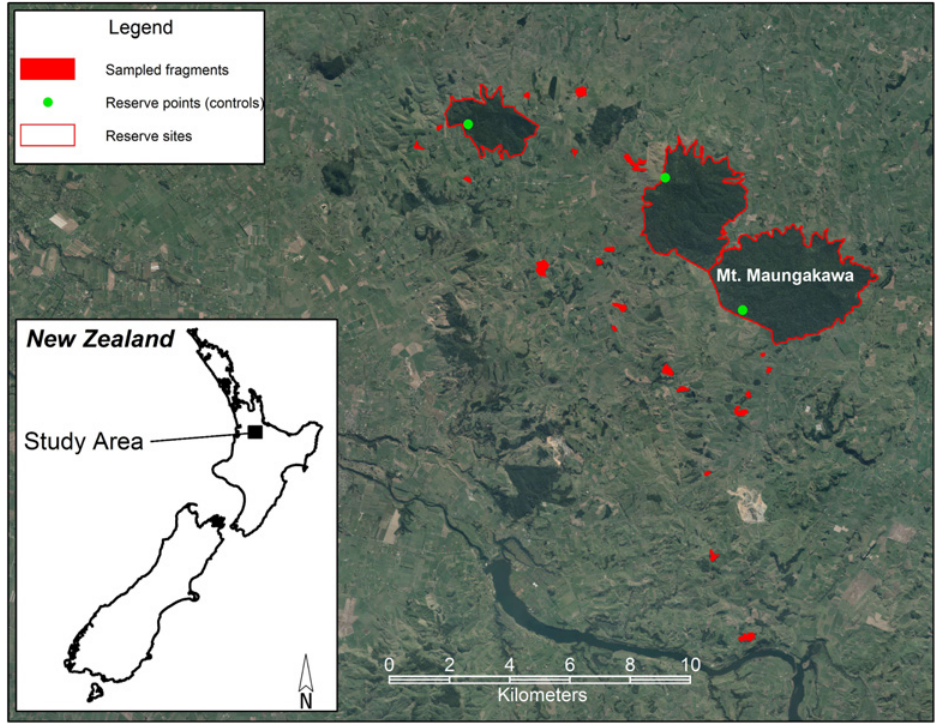
Figure 1. Locations of the study sites in the Waikato region of northern New Zealand. Imagery © Waikato Regional Aerial Photography Service (WRAPS) 2012. Imagery sourced from Waikato Regional Council. Licensed for re-use under the Creative Commons Attribution 3.0 New Zealand license (http://